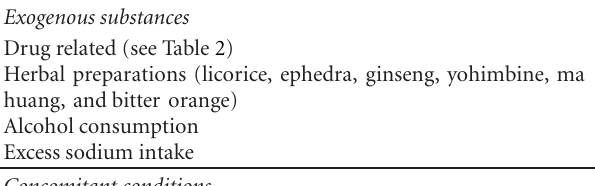
Table 1: Causes of resistant